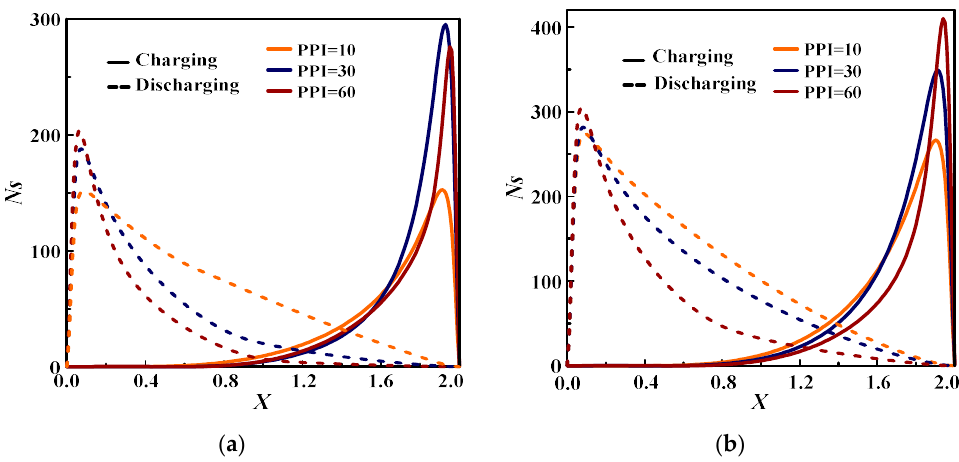
10 of 15 Figure 7. Pore density effect on LTNE criteria for Re=400 during: ( a ) charging case; ( b ) discharging case. 4.3. PPI’s Effecton the Dimensionless Entropy Generation Rate The entropy generation rate is an indicator used to assess the system stability. Fig- ures 8–10 outline the pore density effect on the dimensionless entropy generation rate during changing and discharging processes for Re=200 and 400 at 0.7, 0.8  